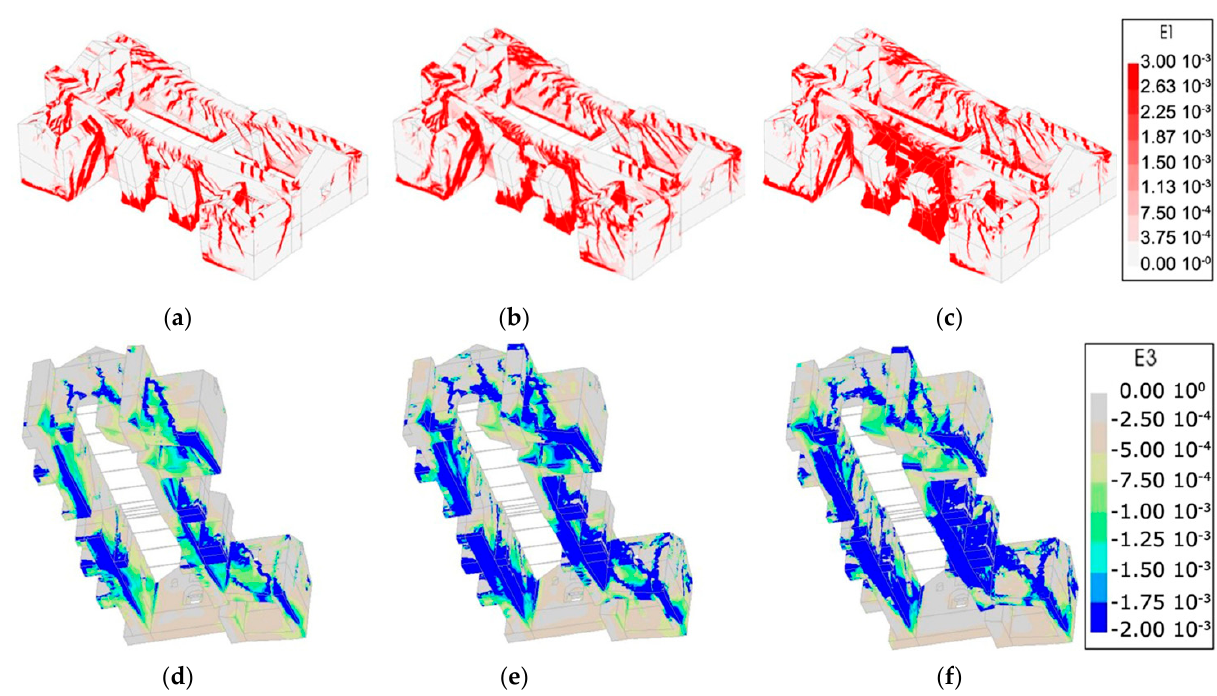
Figure 22. Distribution maximum principal strain in − YY direction at the ultimate stage of ( a ) NTC 2018, ( b ) KADET 2021 and ( c ) ASCE41-13. Distribution minimum principal strain in − YY direction at the ultimate stage of ( d ) NTC 2018, ( e ) KADET 2021 and ( f ) ASCE41-13.